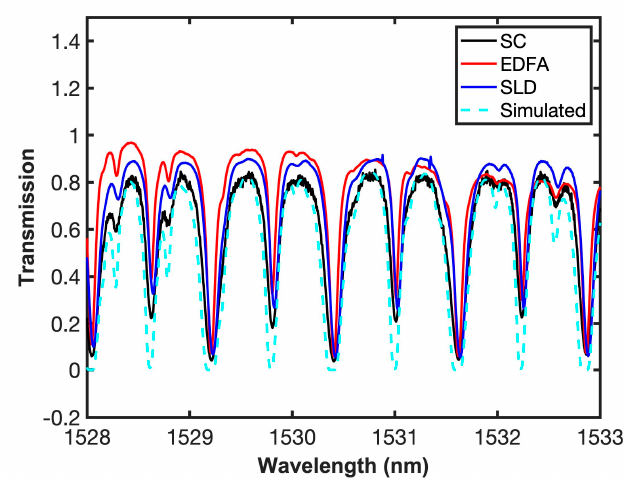
Figure 7. Measured and simulated gas transmission with SC, SLD, and EDFA.